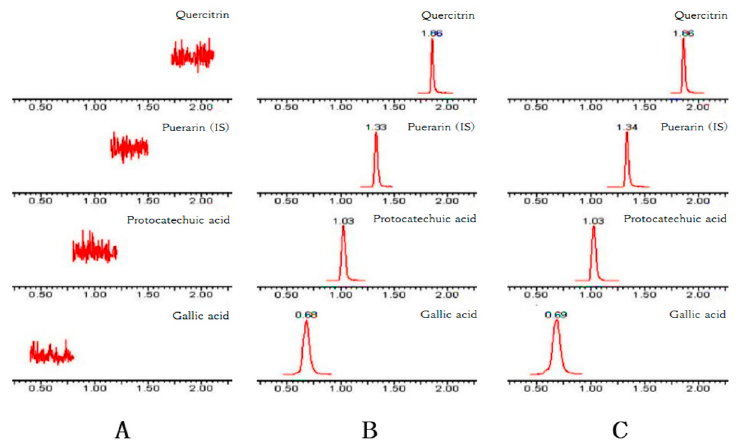
Figure 2. Representative chromatograms of GA, PCA, QR, and puerarin (IS) in ( A ) blank plasma; ( B ) blank plasma spiked with GA, PCA, QR, and IS; and ( C ) plasma at 30 min after the oral administration of 10 g/kg Polygonum capitatum extract.